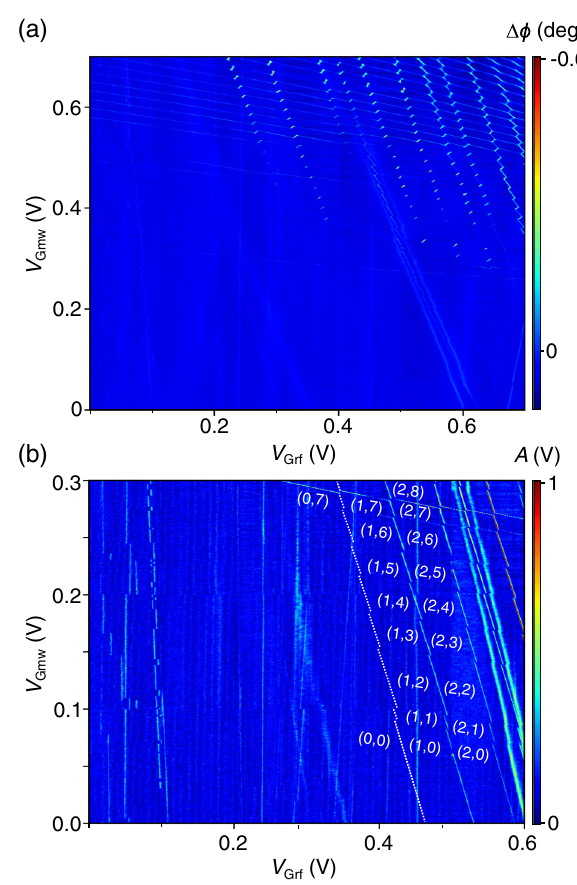
FIG. 4. Charge stability diagrams of the DQD recorded using dispersive gate-based readout, where panel (a) is similar to Fig. 1(b) without the inset and panel (b) is a zoom-in on the few-electron regime showing the amplitude A instead of Δ ϕ of the IQ demodulated response. The dotted white line indicates the addition of the first electron to QD , its location determined by rf mimicking the ð 1 ; n Þ − ð 2 ; n Þ line and placing it at the position of the first visible ICT involving zero electrons in QD , i.e., (0,8)- rf (1,7). Panels (a) and (b) are stitched together by 49 and 18 individual measurements,